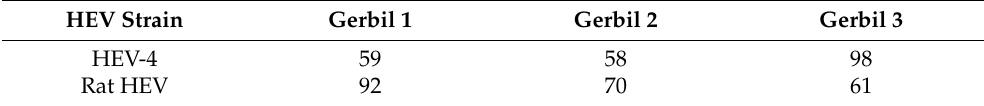
Table 2. ALT (IU/L) in the sera collected from Mongolia gerbils on day 14 p.i. HEV Strain Gerbil 1 Gerbil 2 Gerbil 3 HEV-4 59 58 98 Rat HEV 92 70 61